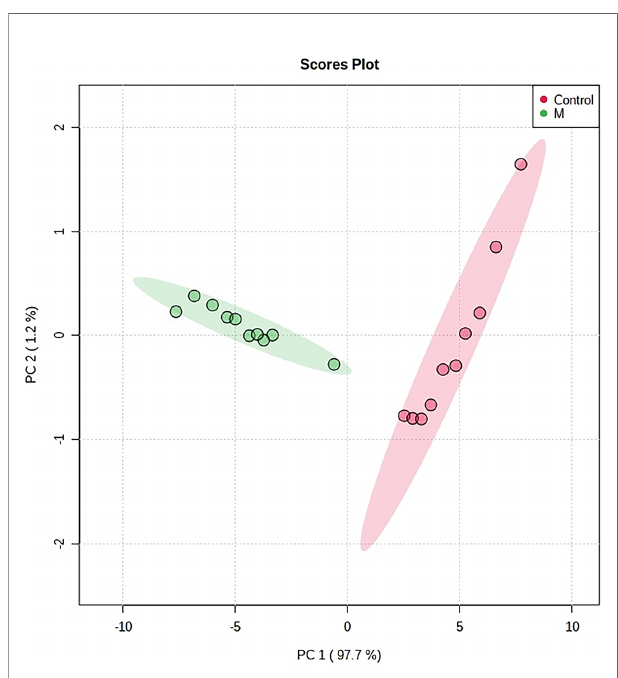
FIGURE 1 | The PCA scores plot of urine samples from the control group and the model group. M, model group. The red dot indicates the control group, and the green dot indicates the model group.